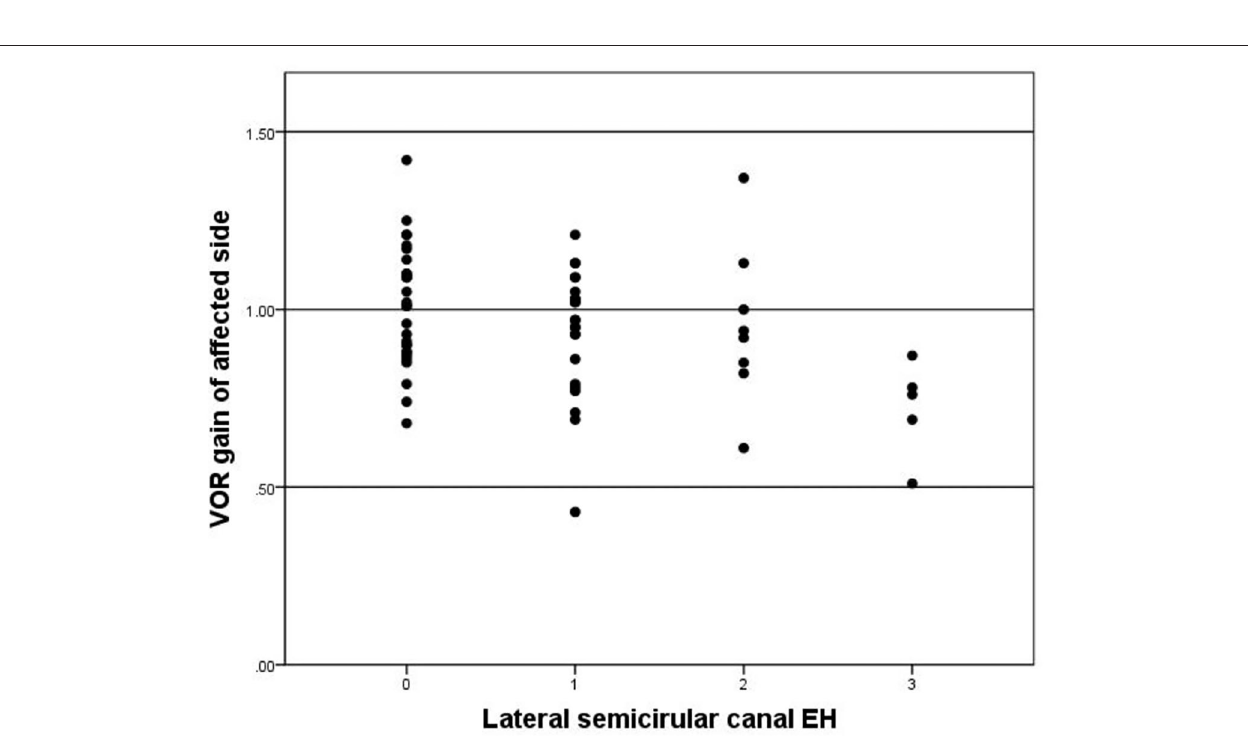
FIGURE 6 | Correlation between grade of lateral semicircular EH (x-axis) and VOR gain of affected side (y-axis). The negative correlation is significant ( r = − 0.311, p = 0.012).